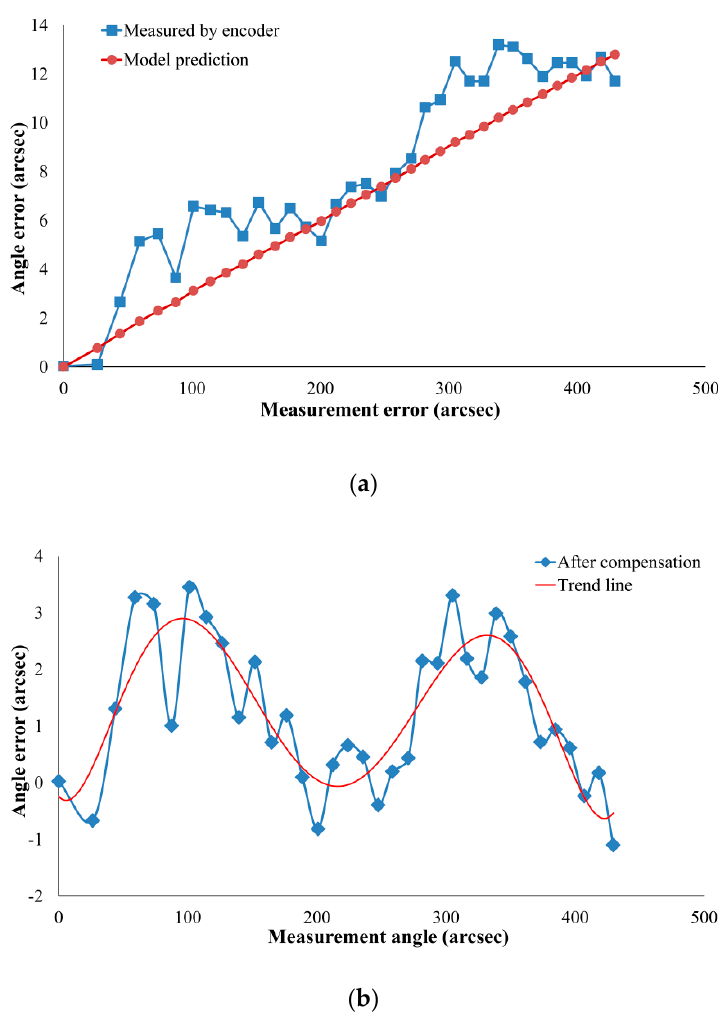
Figure 8. ( a ) Comparison between model prediction error and encoder measurement error. ( b ) Errors after compensation. Table 4. Measurement data and compensation data.